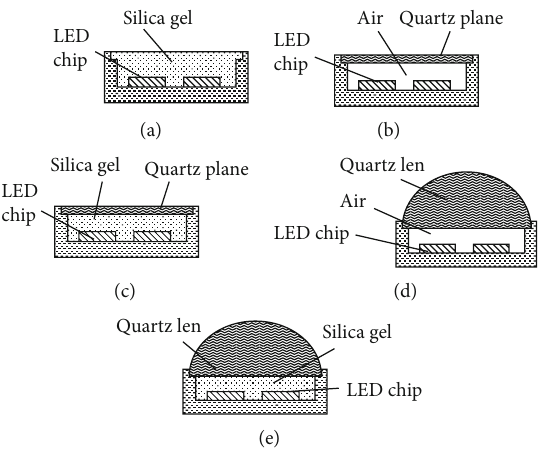
Figure 1: Diagram of di ff erent package structures.